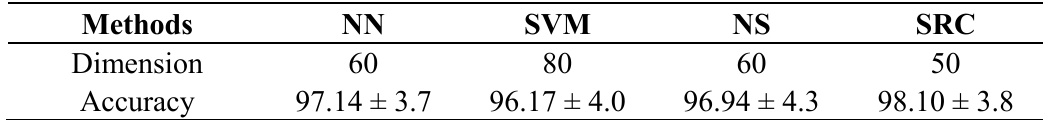
Table 2. Best results (%) of different methods with reduced dimension of Gabor wavelets representation.